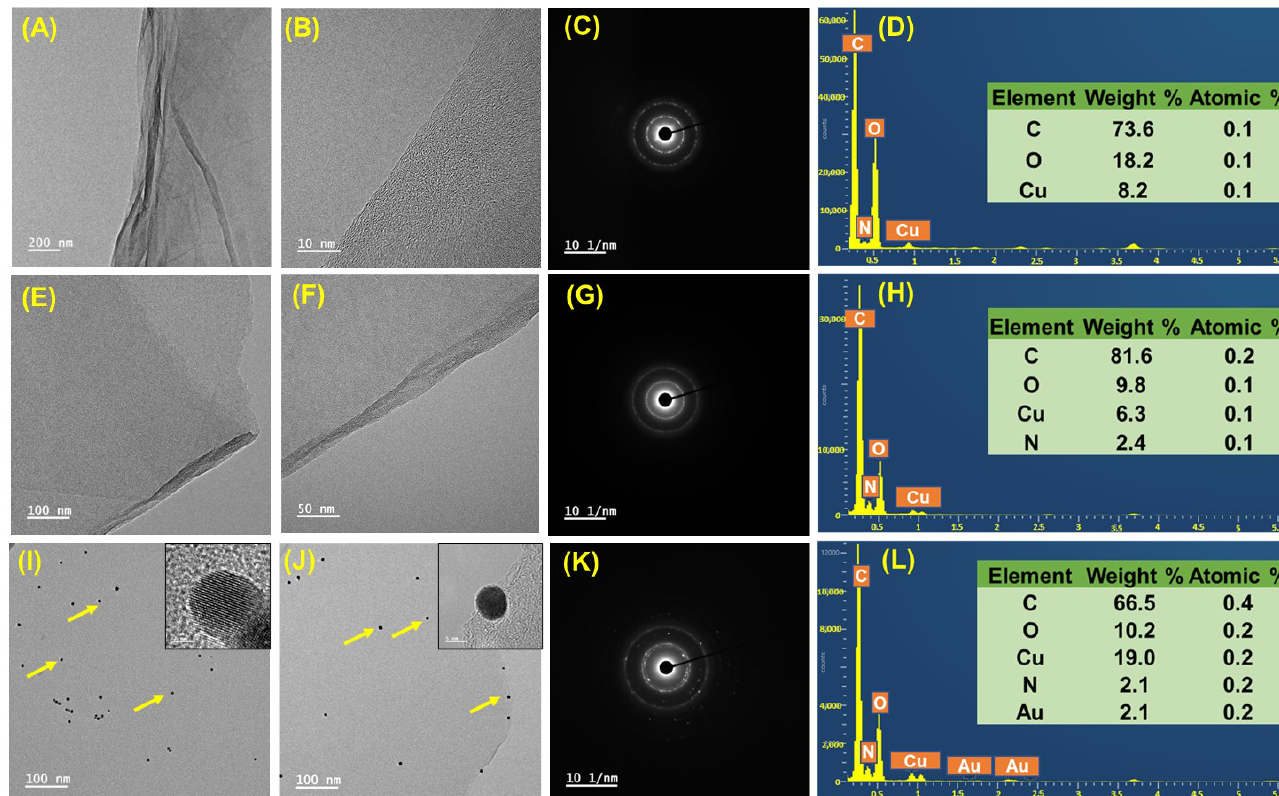
Figure 3. This is a figure. Schemes follow the same formatting. If there are multiple panels, they Figure 2. TEM micrograph of GO ( A , B ), rGO-PDA ( E , F ), AuNP ( I ), rGO-PDA-AuNP ( J ); SAED should be listed as: ( a ) Description of what is contained in the first panel. ( b ) Description of what is pattern of GO ( C ), rGO-PDA ( G ), rGO-PDA-AuNP ( K ), EDS of GO ( D ), rGO-PDA ( H ), and rGO- contained in the second panel. Figures should be placed in the main text near to the first time they PDA-AuNP ( L ); yellow arrows indicate the sight of AuNPs in the nanocomposite in images ( I , J ). are cited. A caption on a single line should be centered. Inset images of ( I , J ) are HR-TEM images of AuNP in the respective